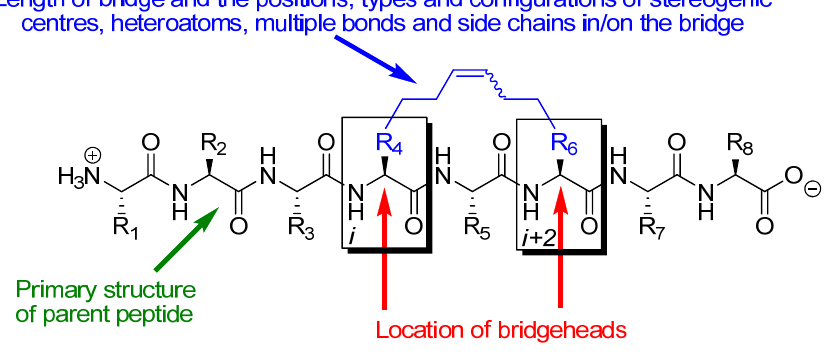
Figure 1. The structural and pharmacological effect of installing an RCM-derived bridge in a peptidic system is dependent on the primary structure of the parent peptide, the length of the bridge, the positions, types and configurations of stereogenic centres, heteroatoms, multiple bonds and side chains in/on the bridge, and the relative and absolute positioning of the bridgeheads along the backbone. If the bridgehead atoms are α -carbons the stereochemistry at the bridgehead atoms is also of